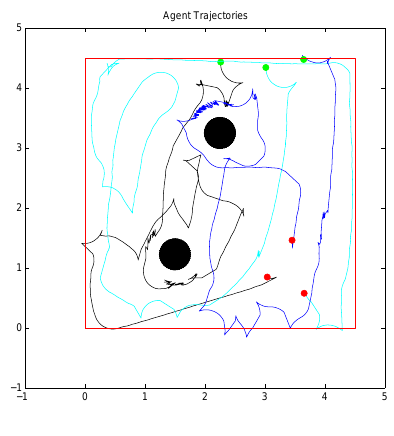
Fig. 13. Robot trajectories for Experiment 1.